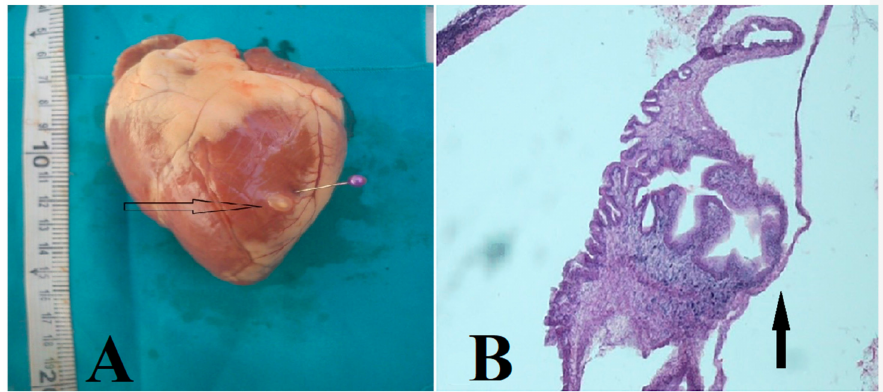
Figure 1. Taenia ovis cysticercus ( A ) and cross-section with protoscolex 10x magnification (H and E) ( B ) in cardiac muscle of sheep slaughtered in the Najafabad slaughterhouse, Isfahan, Iran.